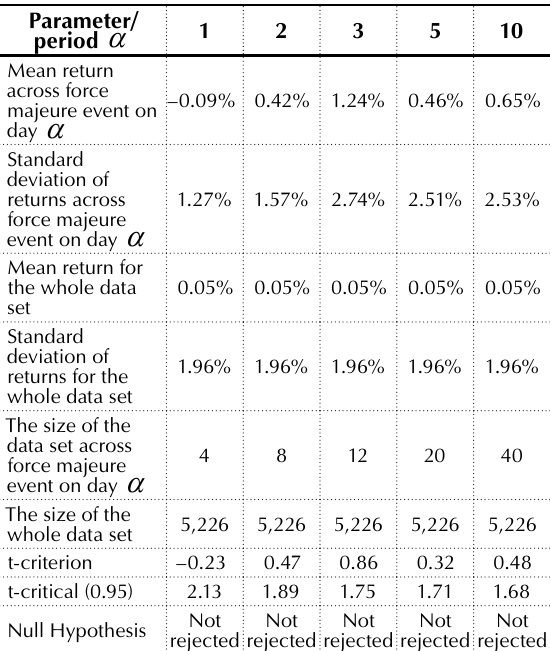
Table 11. T -test for the PFST returns over the period 1991–2018: case of natural disasters